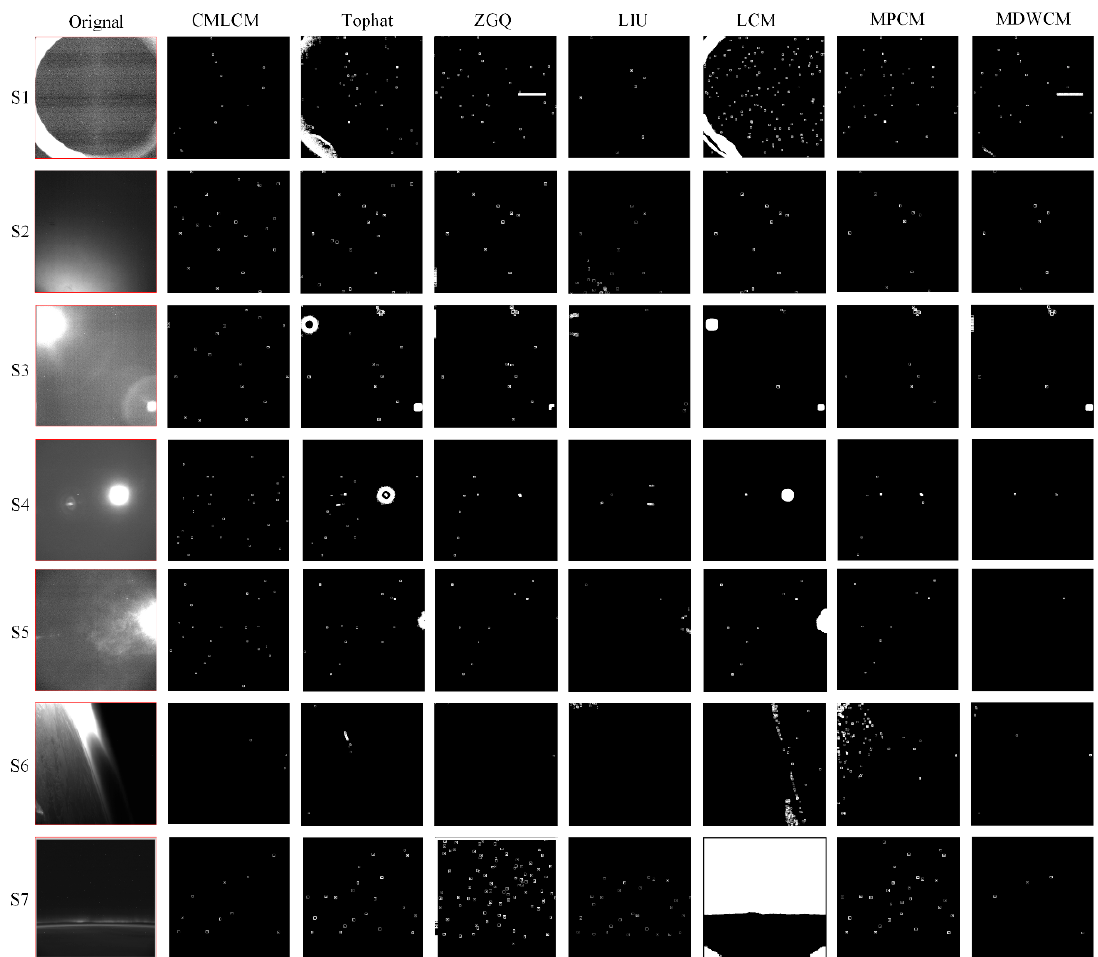
Figure 13. Comparison of the extraction effects with different algorithms in seven sequences.